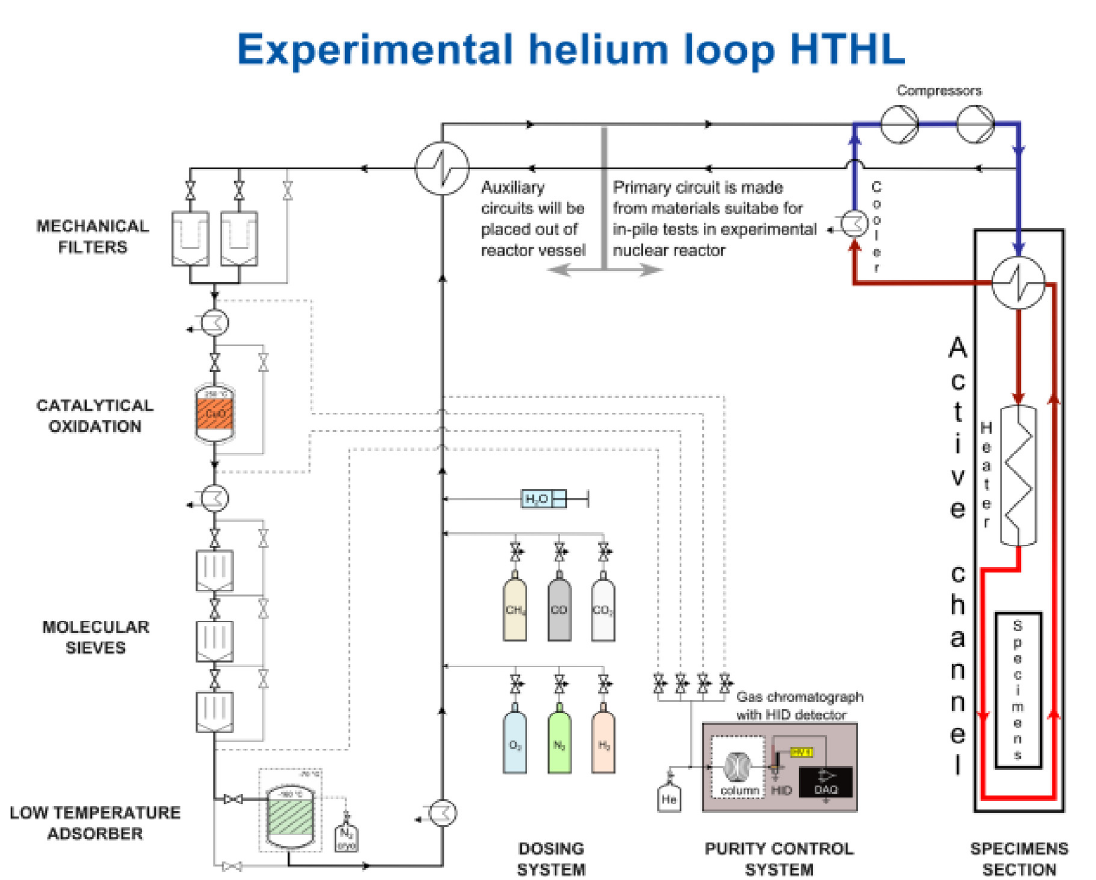
Fig. 1. Scheme of the High Temperature Helium